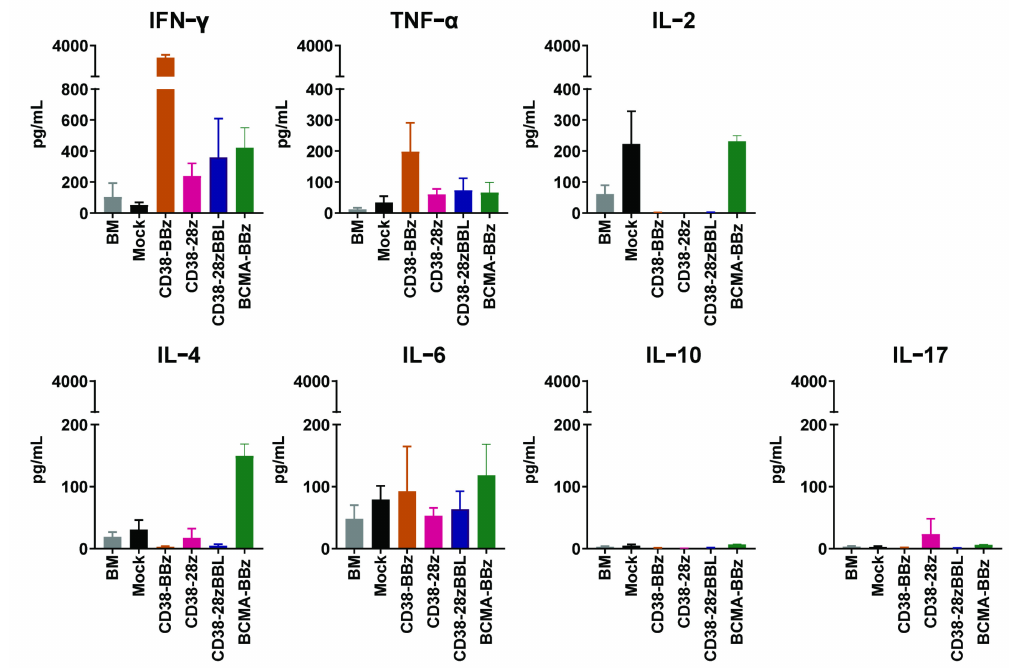
Figure 4. Cytokine production of CD38-CAR iNKT and BCMA-CAR iNKTs in response to primary BM-MNCs from MM patients. After co-incubation with BM-MNC samples, cell supernatants were harvested to measure cytokine secretion with a flow cytometry-based assay. Graph shows the secretion of IFN- γ , TNF, IL-2, IL-4, IL-6, IL-10, and IL17. Error bars indicate standard error of the mean (SEM) ( n = 3 independent CAR iNKT batches, generated from three healthy